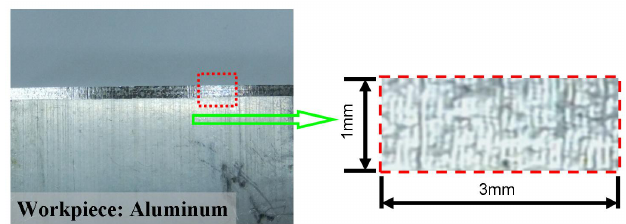
Figure 21. Micrograph of finished workpiece (aluminum).